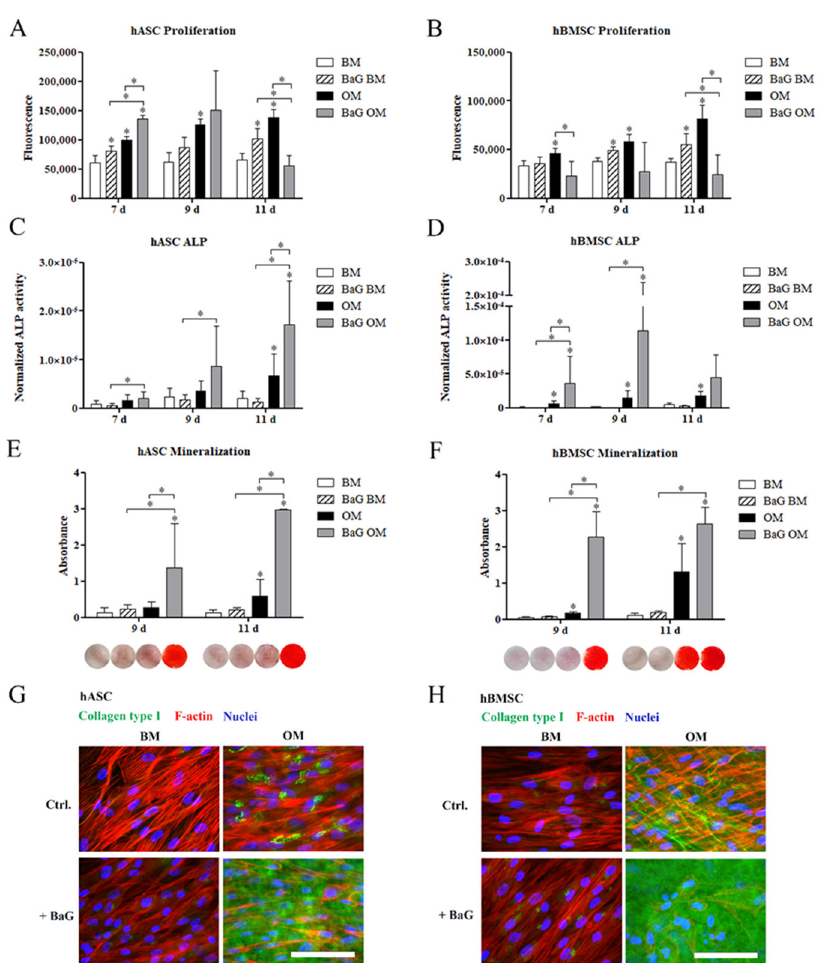
Figure 1. Cell proliferation and osteogenic differentiation of hASCs and hBMSCs. hASCs and hBMSCs were cultured in BM, BaG BM, OM, and BaG OM. ( A , B ) Cell proliferation was studied with CyQUANT assay after 7, 9, and 11 days of culture. ( C , D ) ALP activity was studied after 7, 9, and 11 days of culture and is presented normalized, with the corresponding cell amounts. ( E , F ) Matrix mineralization was analyzed with Alizarin Red staining after 9 and 11 days of culture. Qualitative representative results (stained wells, area 1.9 cm 2 ) are presented below the corresponding graphs. Bright red staining represents the mineral. ( G , H ) Representative images of collagen type I stained hASCs and hBMSCs at 11 d. Scale bars 100 μ m. Statistical analysis: cell proliferation and ALP analyses; N = 9, independent biological replicates of three donors of each cell type. Mineralization; hASCs: N = 9 independent biological replicates of three donors; and hBMSCs: N = 6 independent biological replicates of two donors. Statistical analysis was conducted within time point, * p < 0.05. The asterisk above the error bar indicates the statistical difference compared to the BM control, other comparisons are indicated with lines. Abbreviations: alkaline phosphatase, ALP; basic me ‐ dium, BM; osteogenic medium, OM; and bioactive glass, BaG.